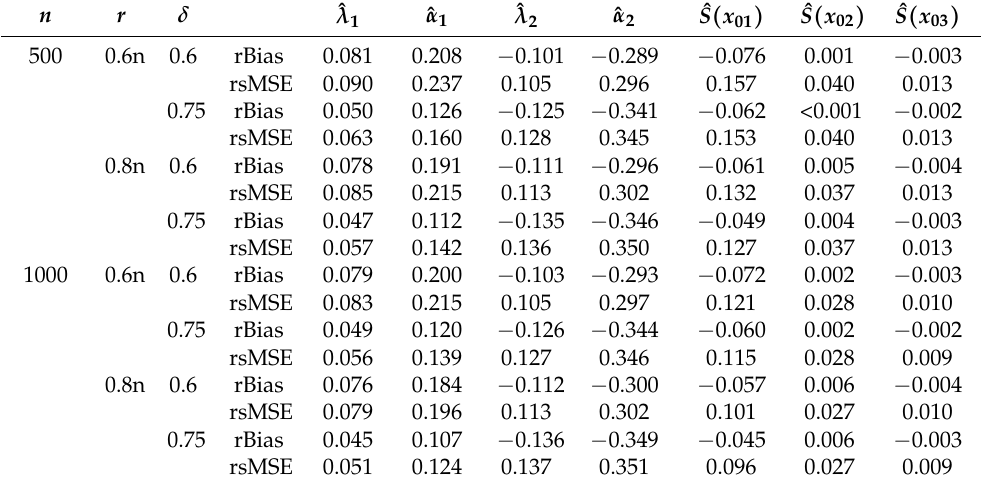
Table 3. Mixture GR distributions model with λ 1 = 1.5, α 1 = 2, λ 2 = 2, α 2 = 4